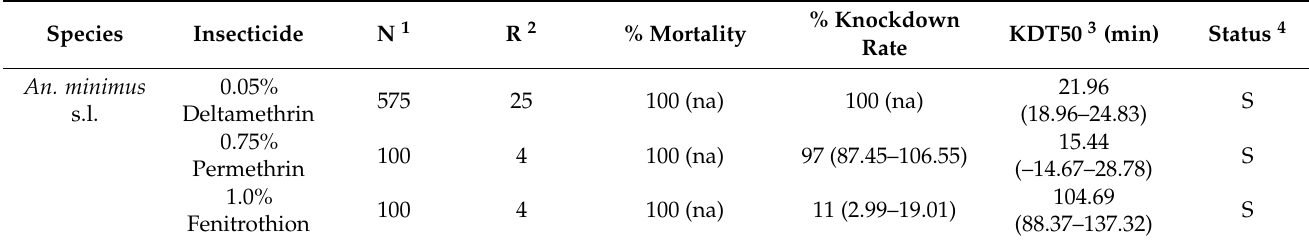
Table 2. Summary results of WHO bioassay tested in An. minimus s.l. and An. maculatus s.l. in Tala Oka